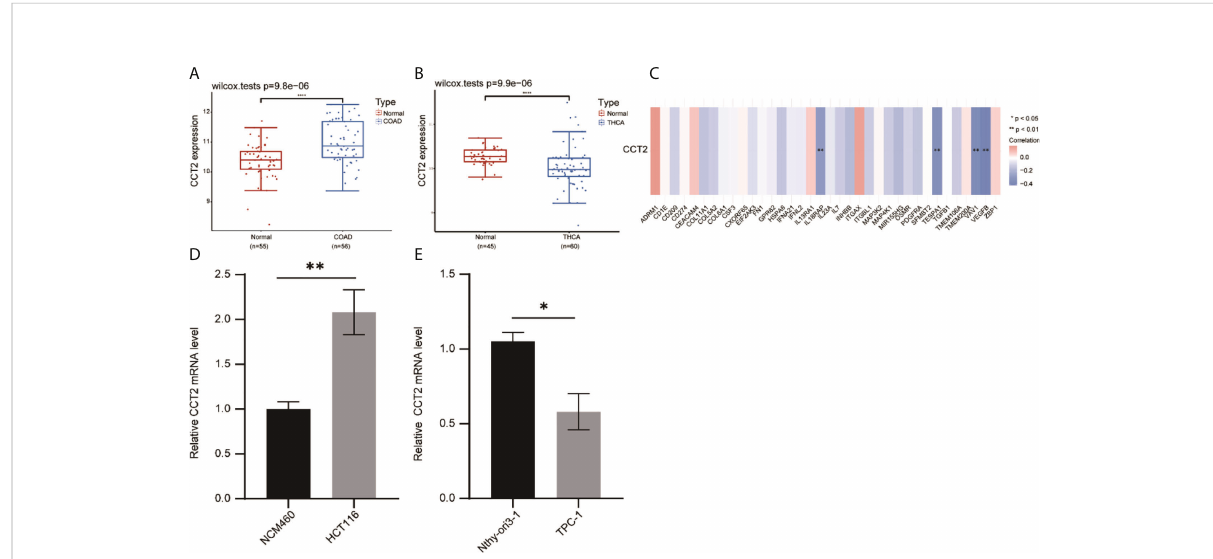
FIGURE 8 Validation of the correlation between CCT2 expression in tumors and immune genes. (A) Expression of CCT2 in colon cancer. (B) Expression of CCT2 in thyroid cancer. (C) Correlation between CCT2 expression and some immune genes in colon cancer. (D, E) RT-qPCR detection of CCT2 expression in colon cancer cells and thyroid cancer cells. * p < 0.05, ** p < 0.01, **** p <